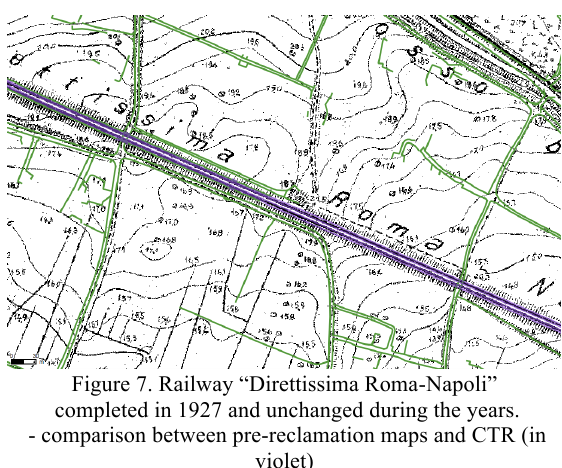
Figure 7. Railway “Direttissima Roma-Napoli” completed in 1927 and unchanged during the years. - comparison between pre-reclamation maps and CTR (in